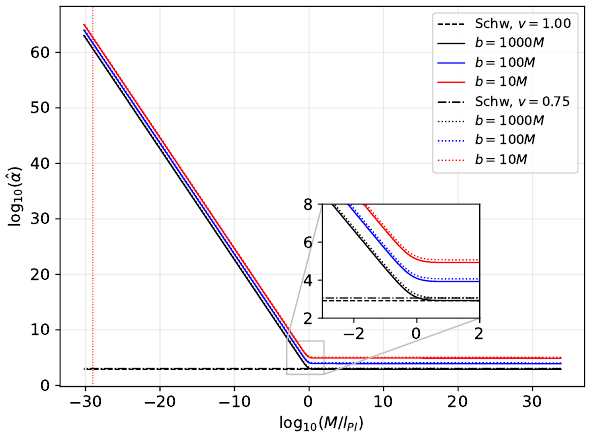
Figure 5. Weak deflection angle by quantum black hole. The red vertical dotted line corresponds to the mass of